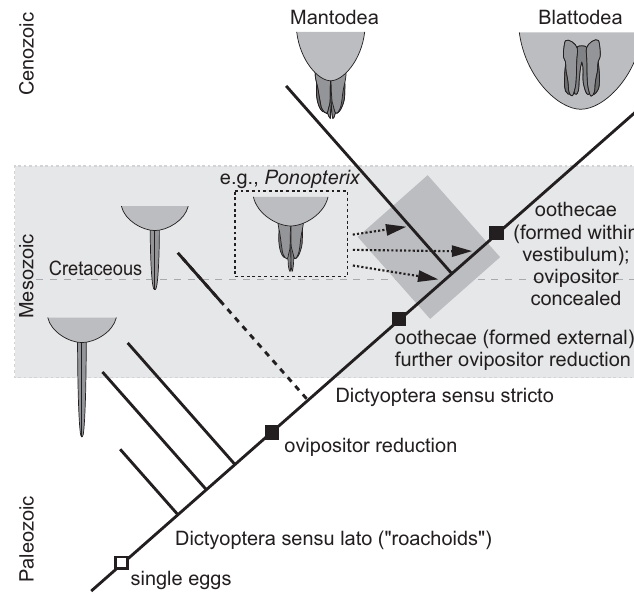
Fig. 17. Proposed evolution of ovipositor morphology in